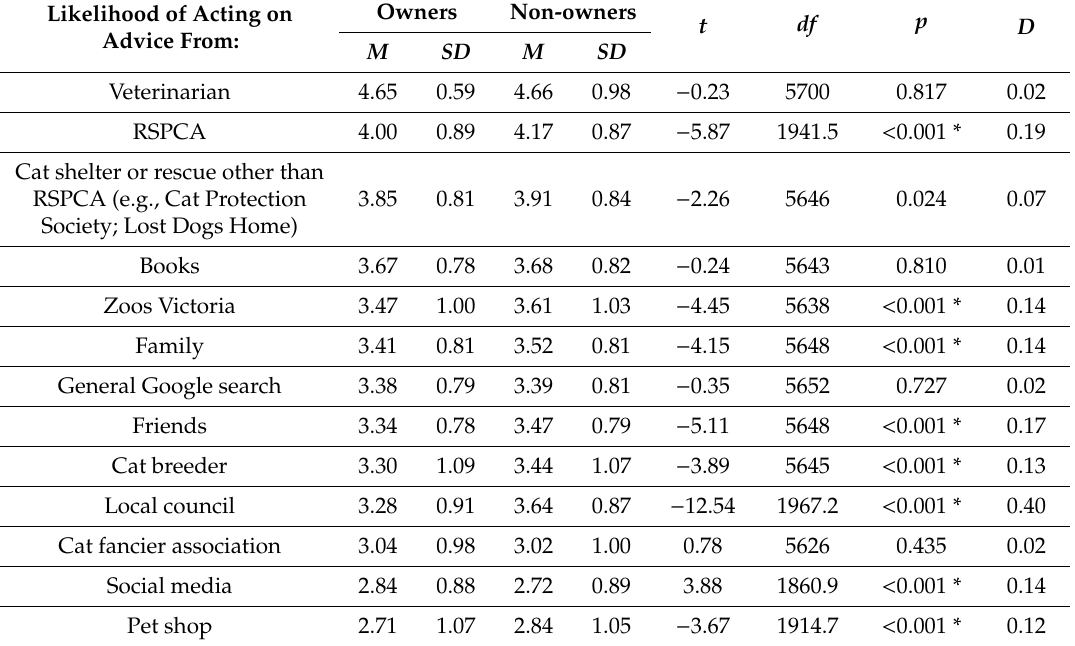
Table 5. Means ( M ), standard deviations ( SD ), and t -test results comparing cat owners and non-owners on likelihood of accepting advice on cat care and management from various sources. Cohen’s d (d) e ff ect sizes are also presented. Items were measured on a 5-point Likert scale, with higher scores indicating a higher likelihood of relying on that source of advice. Items are listed in order of highest to lowest M for